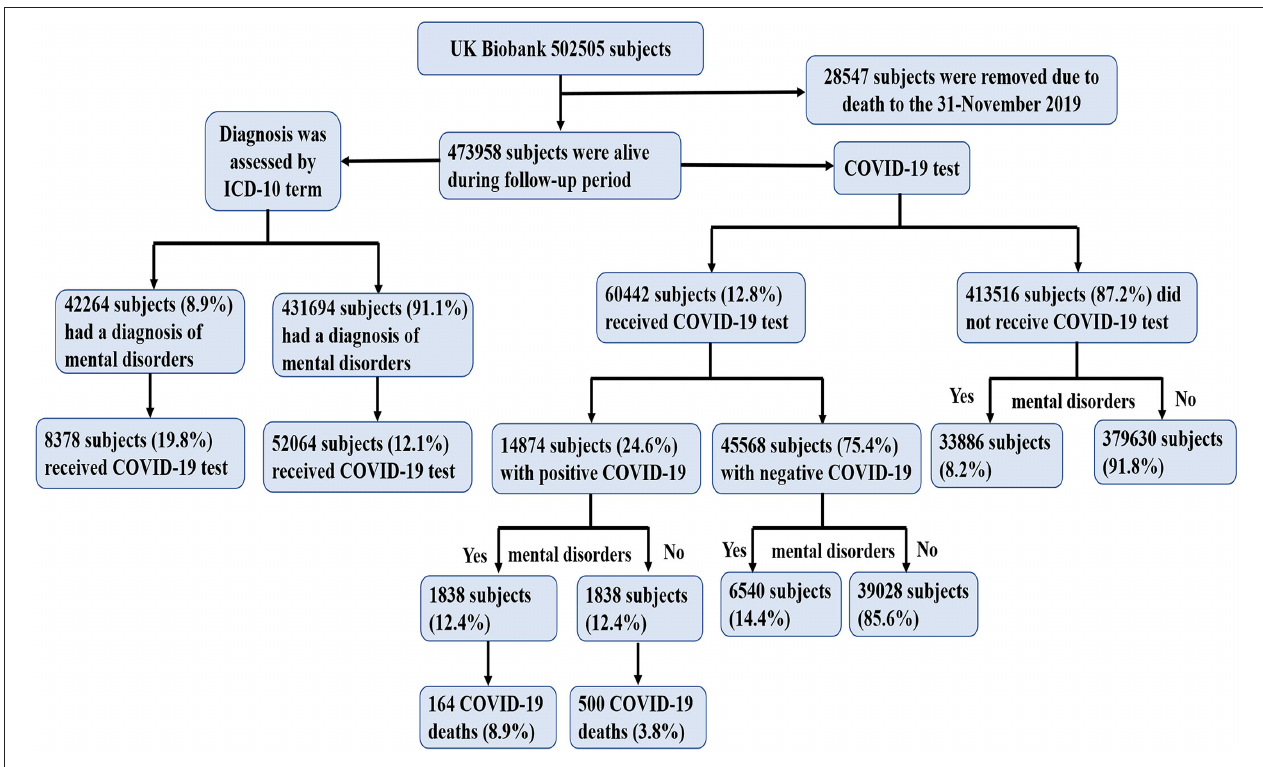
FIGURE 2 | Participant flow diagram with